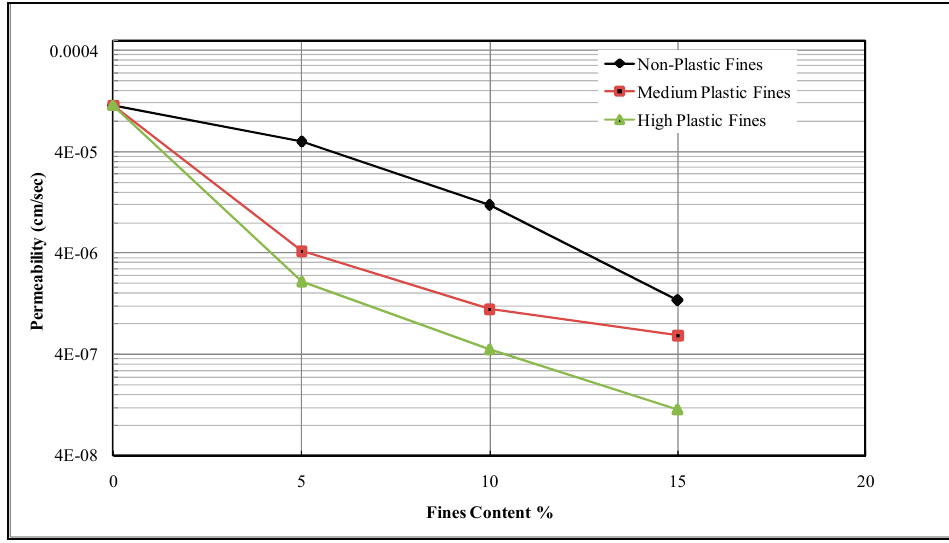
Figure 7. Effect of fines on permeability for the composite samples (gradation C).